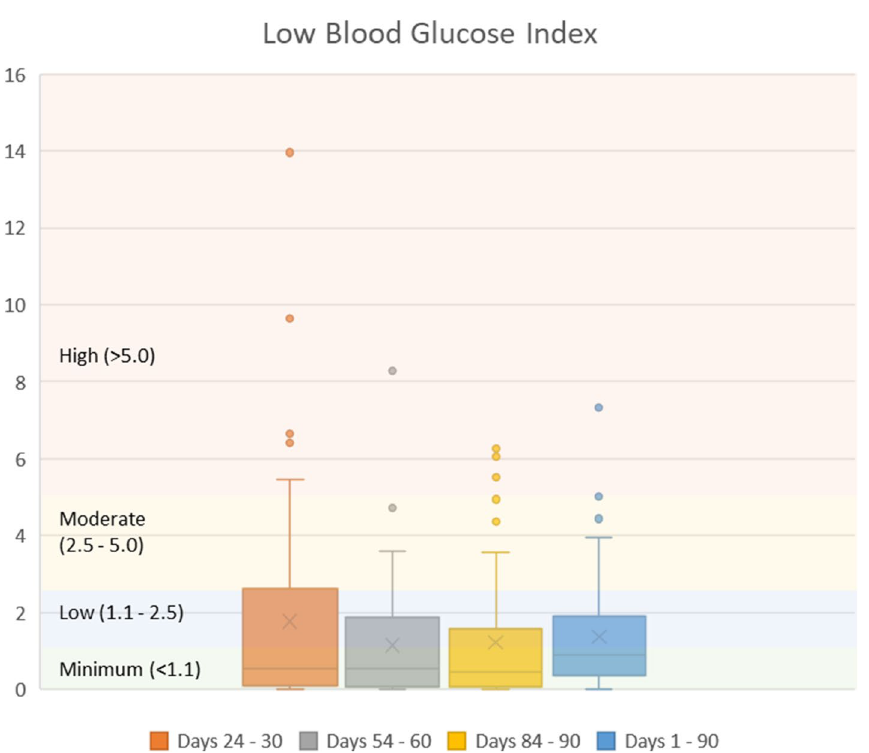
Figure 4. Low blood glucose index during the first 90 days of program